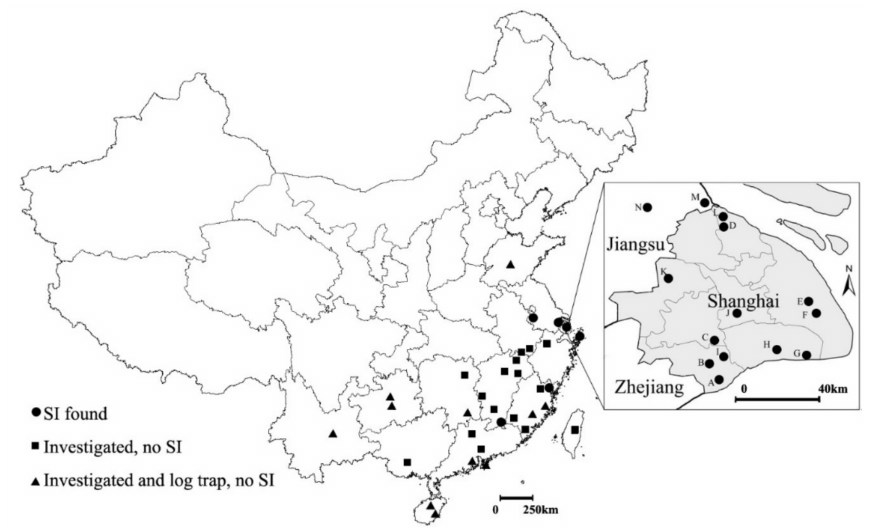
Figure 1. Distribution of SI in China; in the map of Shanghai (right), A–G indicate nurseries surveyed before 2016 [6]; H–N indicate new infestation sites in this study; grey area: Shanghai. SI: sweetgum